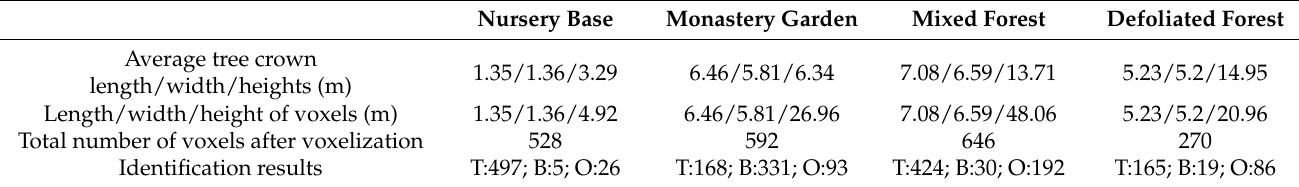
Table 2. Overall accuracy assessment of individual voxels of four testing sites for identifying trees. Nursery